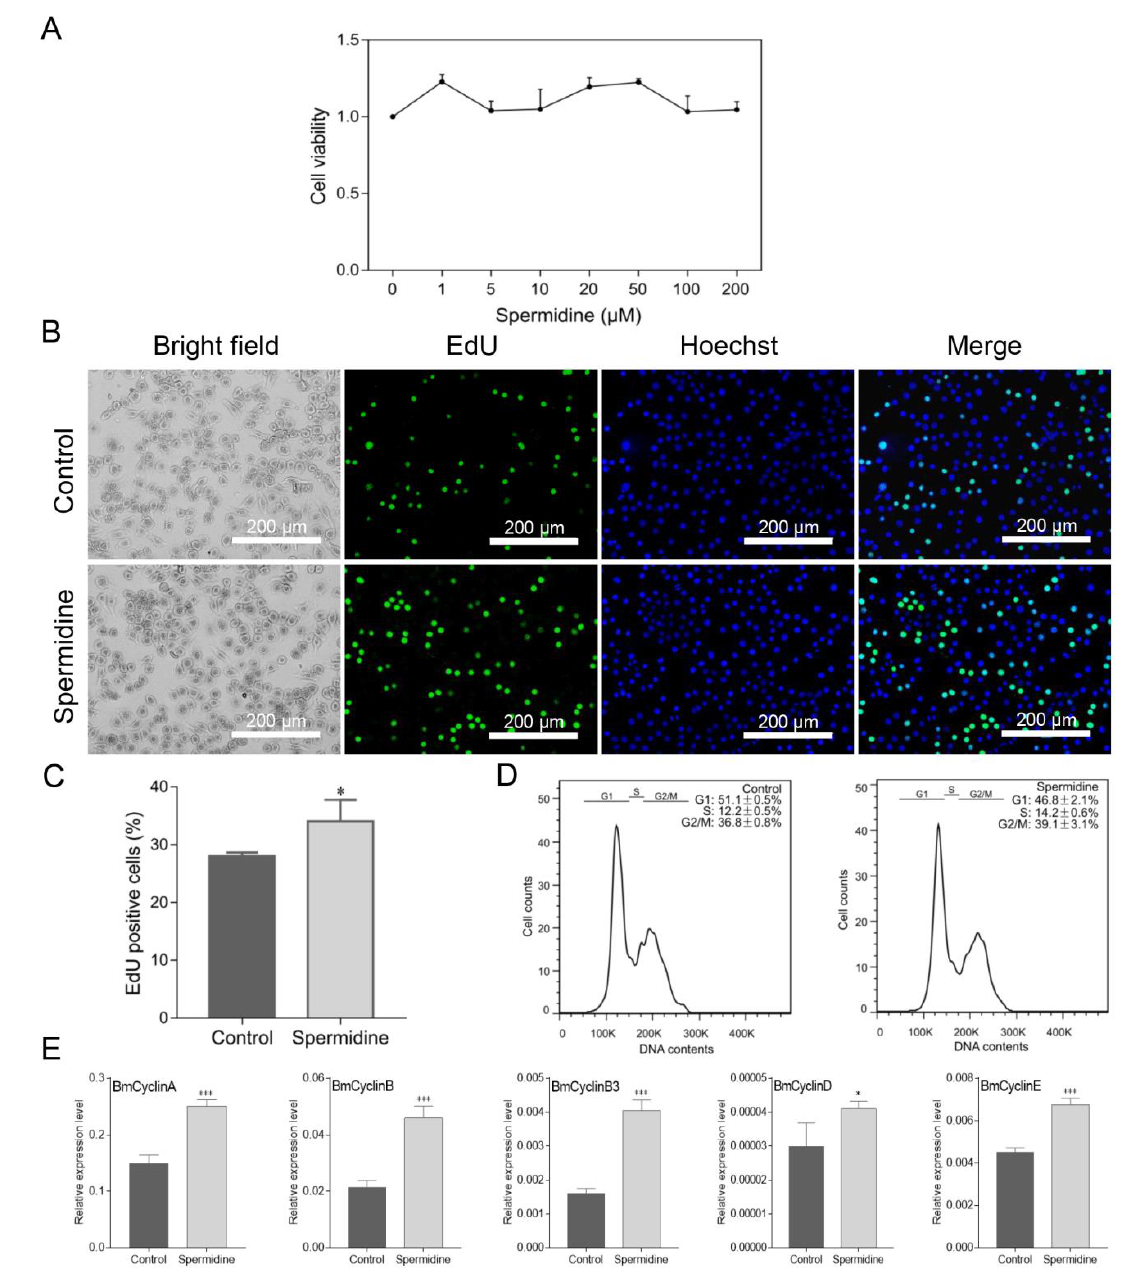
Figure 3. Spermidine supplementation promotes DNA replication in cultured silkworm cells. ( A ) Cytotoxicity test of different concentrations of spermidine on silkworm cells. ( B ) BeyoClick™ EdU-488 staining was used to detect DNA replication. Scale bar, 200 μm. ( C ) EdU-positive cells (green) were analyzed by selecting three different fluorescent fields and counted by Photoshop software. The data presented are the means ± SD ( n = 3). ( D ) Cell cycle distribution was analyzed by using a flow cytometry and cells in G1, S, or G2/M were quantitated by FlowJo software. Three repeats were done for each treatment and the percentage of cells are the means ± SD ( n = 3). ( E ) Expression of cell cycle-related genes was detected by qRT-PCR. For significant analysis: * p < 0.05 and *** p < 0.001.